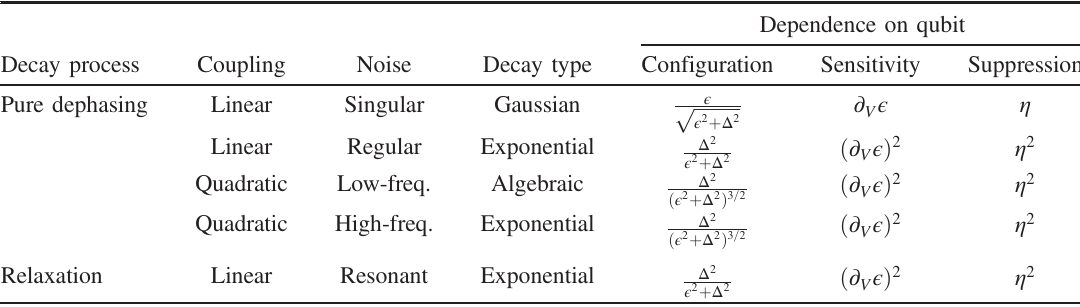
TABLE III. Qualitative dependence of the qubit decay rates on the qubit properties, including the dipole strength η . The “ coupling ” denotes the power with which the noise variable δ V changes the qubit energy; for example, ∝ δ V 2 . “ Singular ” means that the noise diverges at zero frequency, for example, for 1 =f quadratic means δ ℏ ω q noise. For quadratic coupling, the low-frequency and high-frequency parts of the noise spectrum are defined with respect to the inverse evolution time. “ Resonant ” stands for noise relevant only at the qubit frequency. “ Decay type ” denotes the functional form of the decay envelope, such as the one in Eq. (11) which happens to be Gaussian. Qubit “ configuration ” comprises the detuning and tunneling, and “ sensitivity ” denotes the derivative of the detuning with ϵ ≡ ∂ ϵ = ∂ V respect to the fluctuating voltage ∂ , which can be obtained from Eq. (5). Finally, “ suppression ” denotes V G the scaling of Eq. (8). An example how to read this table: For a system dominated by a regular noise coupled linearly to the qubit, the qubit coherence decay is exponential, with a pure dephasing rate Γ φ ∝ Δ 2 = ð ϵ 2 þ Δ 2 Þð ∂ ν ϵ Þ 2 η 2